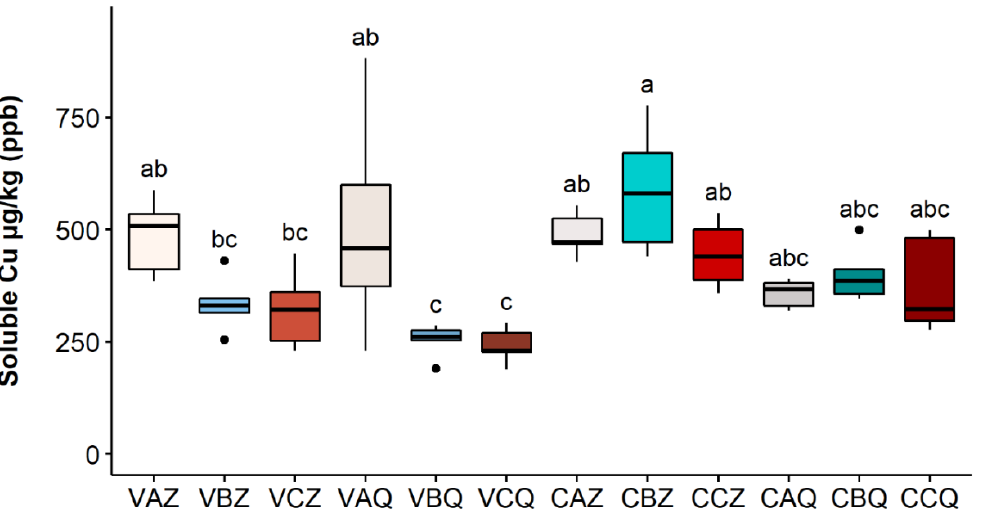
Figure 8. Soluble Cu concentration in each sample in 2021. Lower case letters refer to Dunn’s multiple comparisons (Benjamini–Hochberg p -value adjustment, α -level = 0.05). Codes legend: the first letter refers to the vineyard: (C) Castelplanio, (V) Varano. The second letter refers to the thesis, (A) Cu treatments, (B) Alternate treatments with Cu and chitosan, and (C) Chitosan treatments. The third letter refers to the depth: (Z) 0–20 cm, (Q) 20–40 cm.